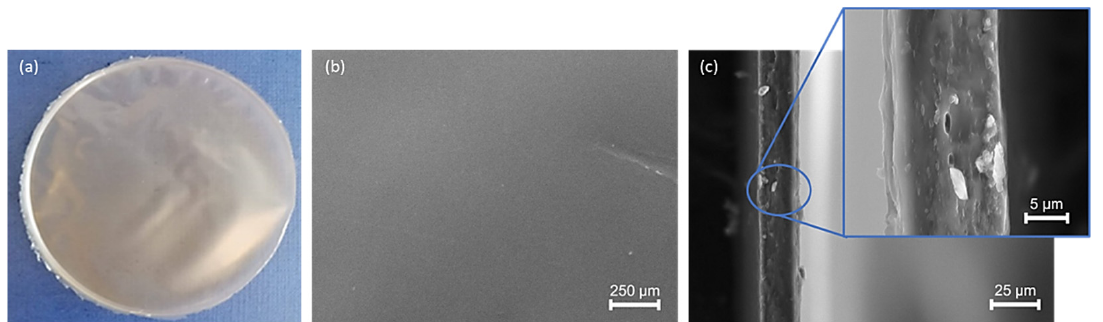
14 of 19 Figure 7 . Rheological profile analysis of olive oil/d − FucoPol emulsion (green) and olive oil/FucoPol emulsion (grey) (o:w weight ratio of 2:3): ( a ) flow curves; ( b ) mechanical spectra: elastic G’ (closed) and viscous G” (open) moduli. 3.5. Film-Forming Capacity 3.5.1. Morphological Characterization The d-FucoPol formed slightly opaque flexible films with a brownish tone (Figure 8a) and a thickness of 45 ± 12 µm (Figure 8c). The films’ transparency was 5.16 ± 1.09, a value higher than that reported for the native FucoPol films (3.67) [5], thus indicating that